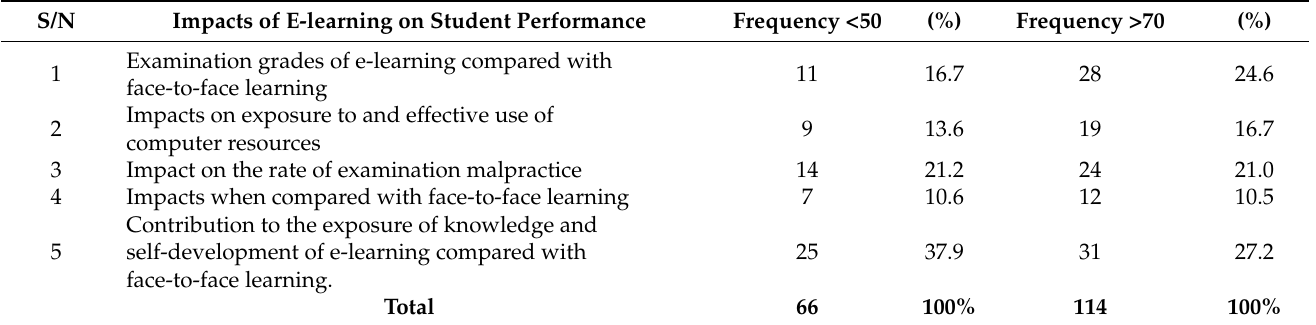
Table 4. Frequencies and percentages of the tools and strategies for effective e-learning